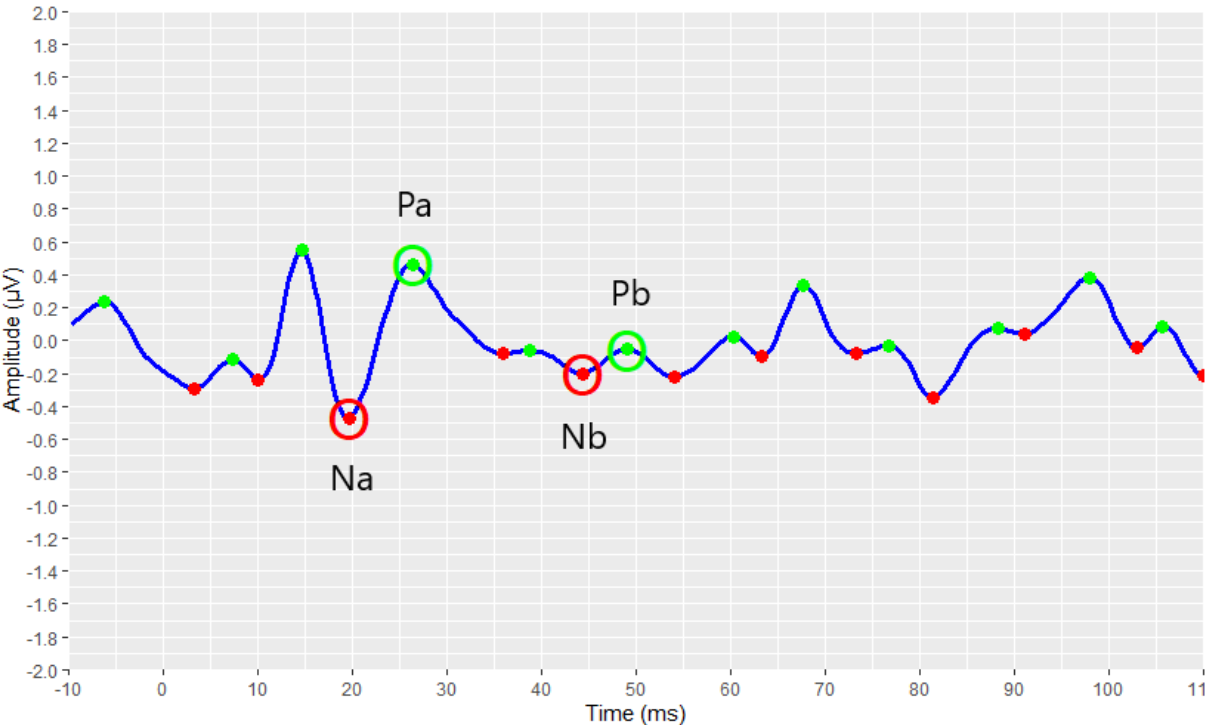
Figure 15. Selecting the waves of interest in a waveform where it is not easy to detect them. The choice of setup for both the stimulus (e.g., the type of stimulus and its intensity) and the acquisition parameters (e.g., the sample rate and the filters used), directly affects the AEP signals. The careful manipulation of stimulus parameters, based on research findings and clinical experience, plays a critical role on the recording quality. The two tools were created from data (waveforms) recorded and extracted from the Eclipse system (module EP25) of Interacoustics, and exactly the same stimulus settings and parameters were used for the recordings for each test. The settings used were those suggested by the clinicians of the UNITI project consortium as being the most appropriate. The application of these automated tools to signals derived from different settings (setup) may not perform as well, given the altered parameters of the received signals. At this juncture, we deemed it useful to mention some previously conducted studies aimed at performing automated annotation of ABR signals [40–42]. In the earliest study identified [40], ABR signals were evaluated using dynamic time warping. Dynamic time warping is a method in which a temporal sequence of values is stretched or contracted, to resemble another sequence. The generated warp-average mimics the waveform of a typical subject more closely than the conventional average does. Hence, each individual’s waveform was compared to a normal template, and in this way, warping could identify the peaks that corresponded most closely to the peaks in the normal template. Although this method can be useful in identifying the waves in normal ABR waveforms, it is not accurate in identifying the waves in abnormal waveforms. In another study [41], the fitted- parametric-peaks (FPP) method provided an automatic evaluation of the quality of ABR signals and parameterized waves III and V, in terms of amplitude, latency, and width. This method was based on the use of synthesised peaks that were adjusted to the ABR response. The study mentioned that the FPP method was tested and evaluated on waveforms from a relatively small number of individuals ( n = 18), all of whom had normal hearing. In addition, no attempt was made to identify I-waves, which are equally useful for the evaluation of ABR signals. The most recent study [42] proposed an automated procedure for extracting individual ABR wave-latencies and amplitudes, based on a well- established non-linear-curve-registration methodology. The implementation procedure involved the pre-processing of individual ABRs and the alignment of the responses, using continuous-monotone time-warping, which carried the danger of over-alignment and therefore was applied with particular care. The waves I and V latencies and amplitudes were retrieved from an ABR data-set consisting of 23 normal healthy subjects and 12